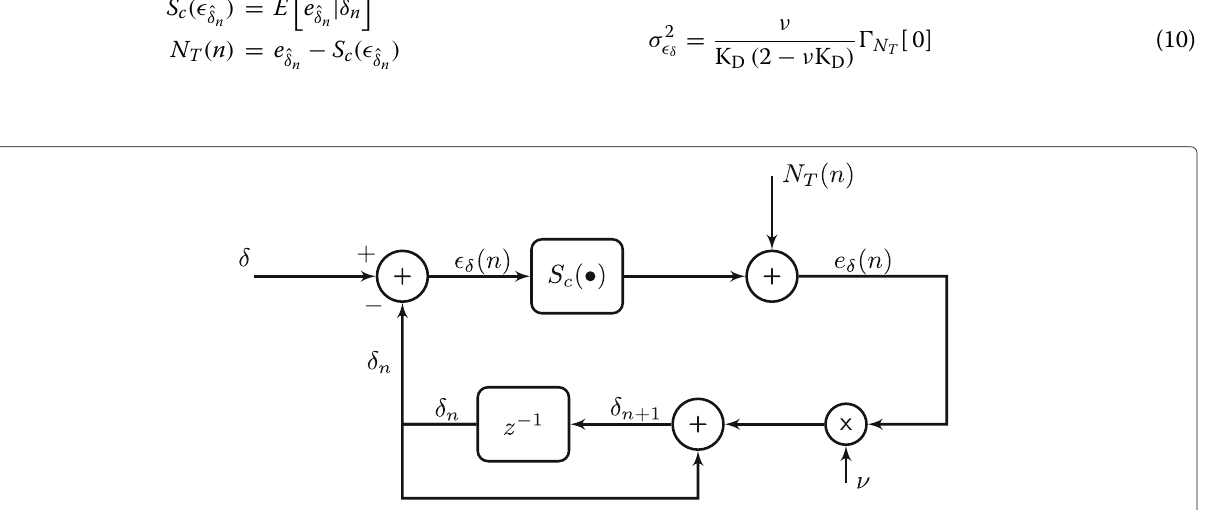
Fig. 3 Equivalent scheme of the FD estimation algorithm as a first-order tracking